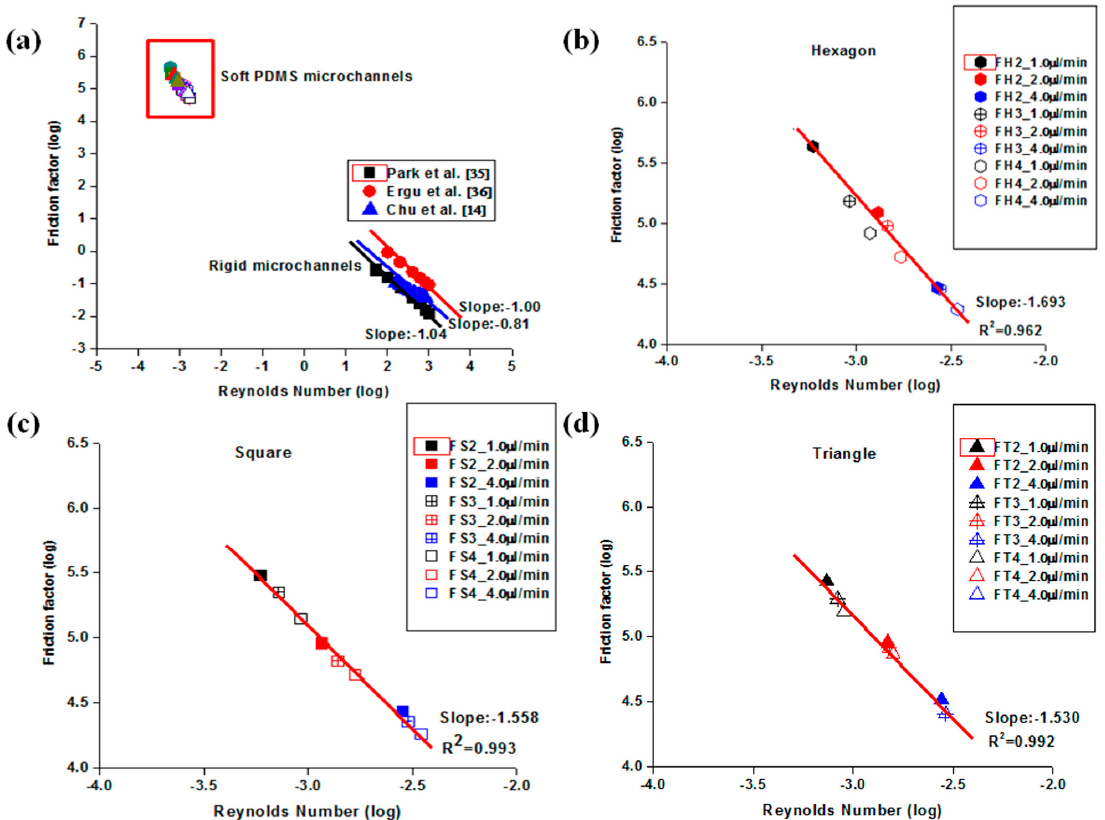
Figure 5. Friction factor as a function of low Reynolds number: ( a ) comparison of this study with rigid microchannel studies; ( b ) analysis of hexagonal obstacles; ( c ) analysis of square obstacles; and ( d ) analysis of triangular obstacles. ( d ) analysis of triangular